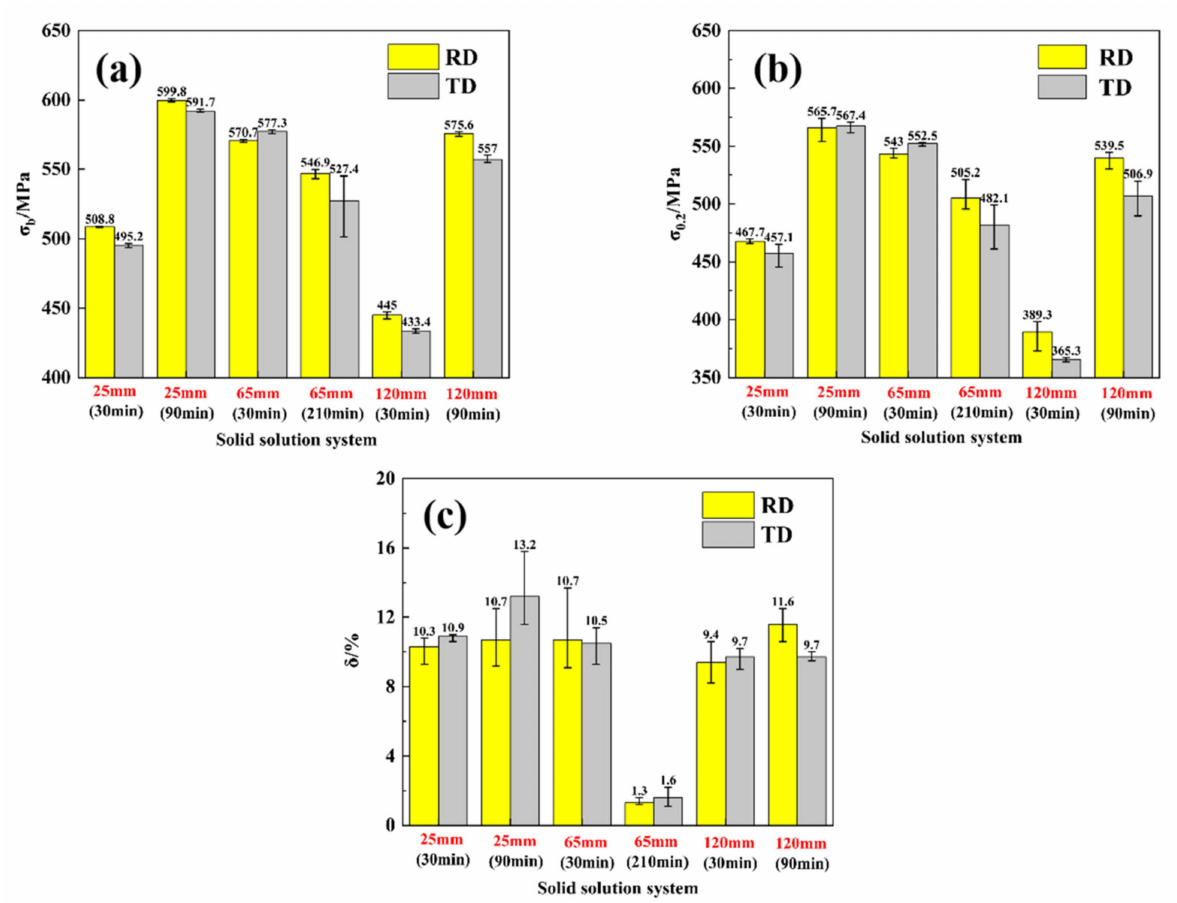
Figure 12. Mechanical properties of the plates after solution and ageing treatments: ( a ) σ b, ( b ) σ 0.2 , ( c ) δ